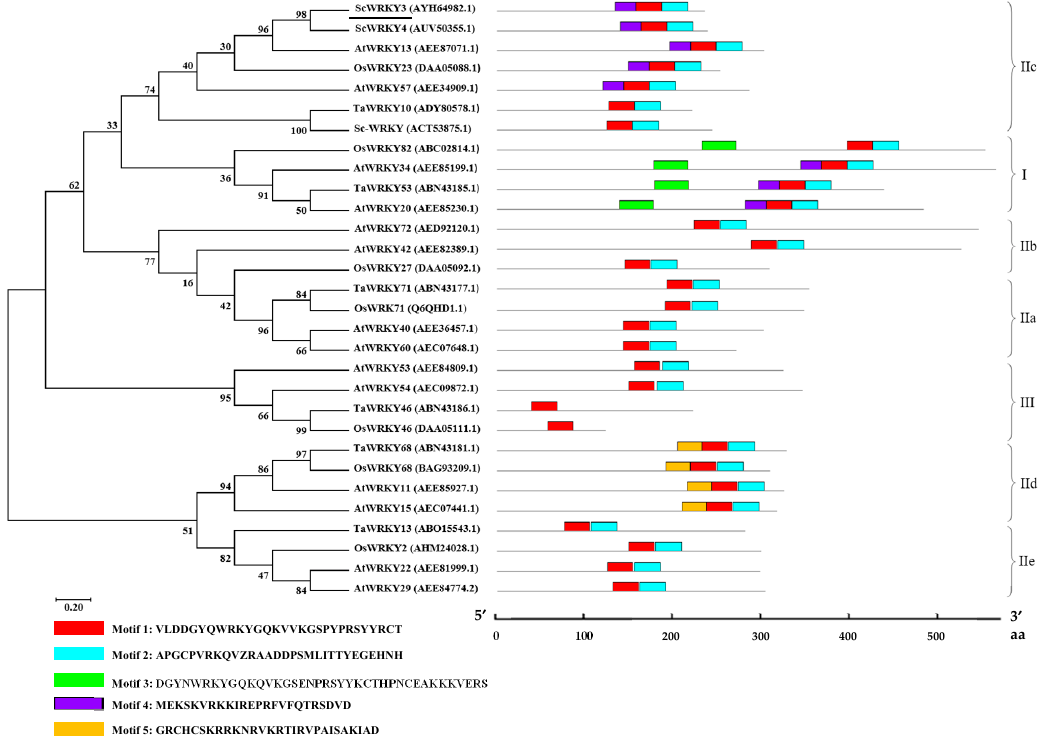
Figure 3. Phylogenetic tree (left) and predicted conserved motifs (right) of ScWRKY3 protein and WRKYs from various plant species. The GenBank accession number of WRKY proteins follows the protein name. Ml, Miscanthus lutarioriparius ; Sb, Sorghum bicolor ; Zm, Zea mays ; Si, Setaria italic ; Os, Oryza sativa ; and At, Arabidopsis thaliana. The unrooted tree is constructed by the Maximum Likelihood with bootstrapping (1000 iterations) using MEGA7.0 software. ScWRKY3 is underlined. The conserved domains were predicted by MEME Suite 5.0.2 software. The different-colored boxes named at the bottom represent conserved motifs. Gray lines represent the nonconserved sequences, and the position of each WRKY sequence is exhibited proportionally. The motif logo is shown in Figure S6.